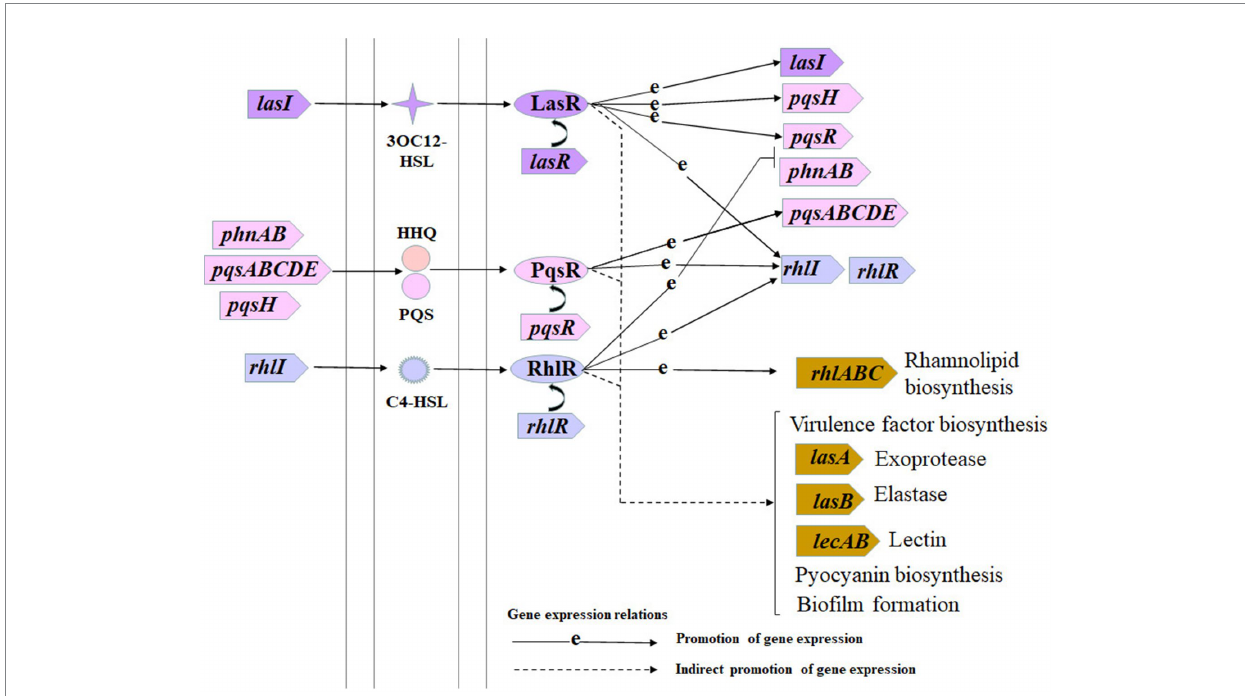
FIGURE 1 Schematic diagram of Pseudomonas aeruginosa hierarchical quorum sensing systems. This schematic diagram is drawn based on the quorum sensing pathway diagram from the Kyoto Encyclopedia Genes and Genomes